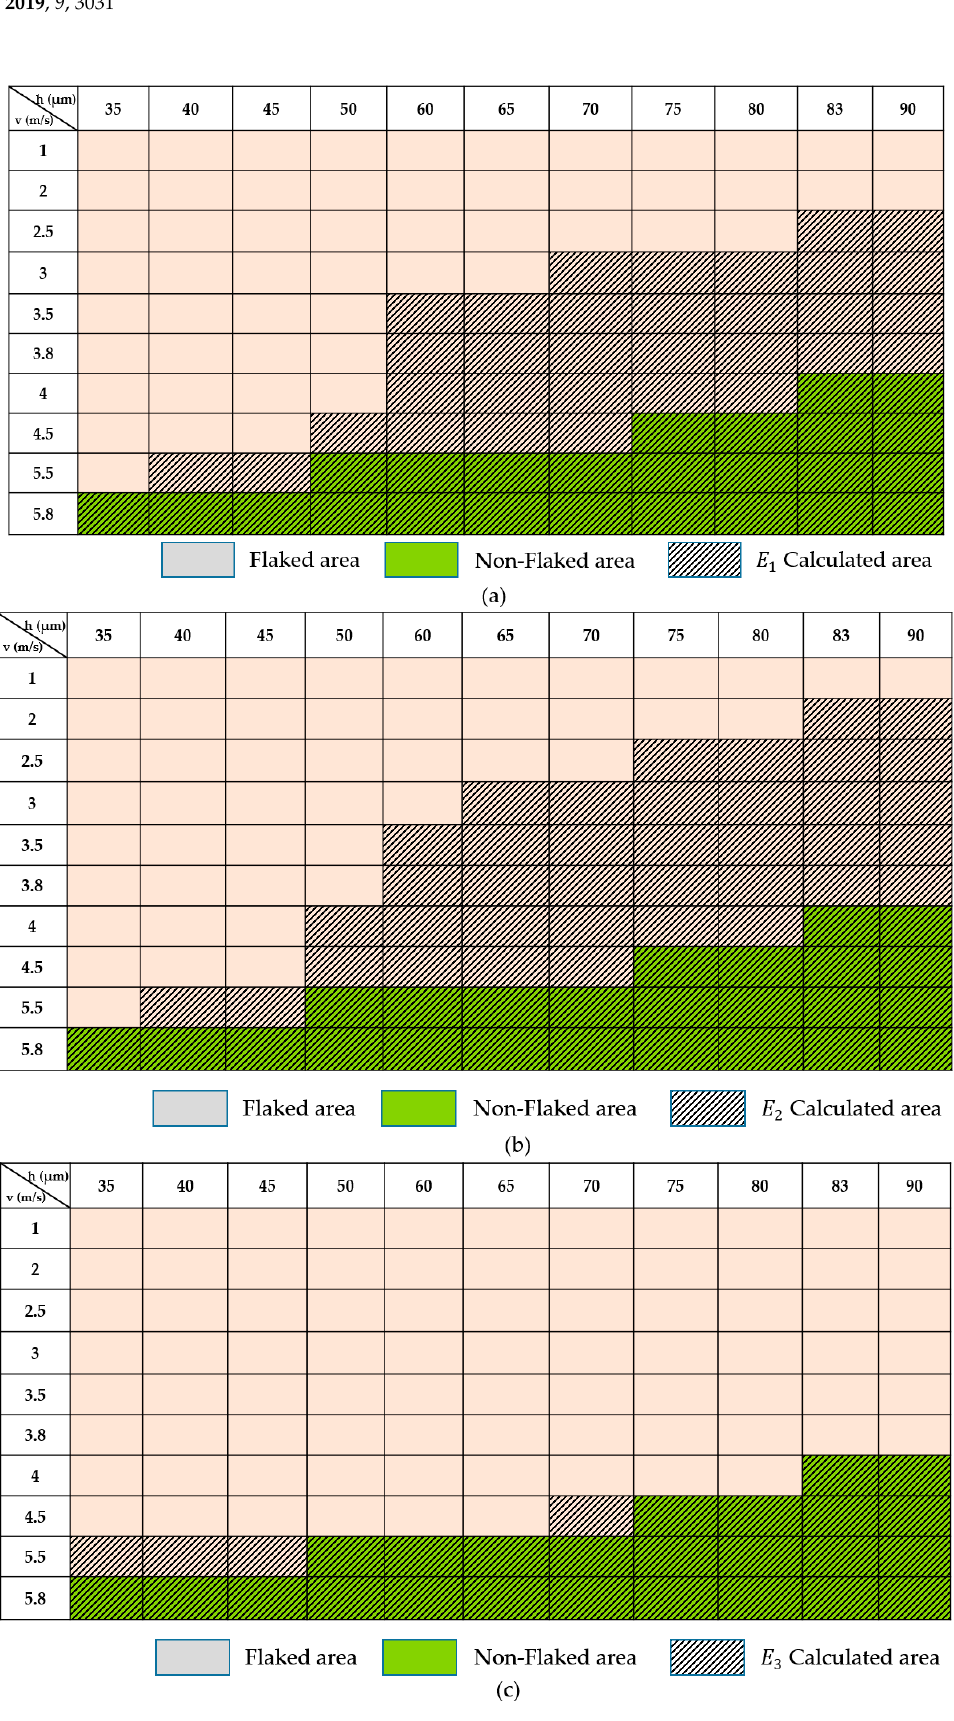
Figure 10. Comparison between experimental results and energy calculated by ( a ) E 1 , ( b ) E 2 , and ( c ) E 3 formulas.